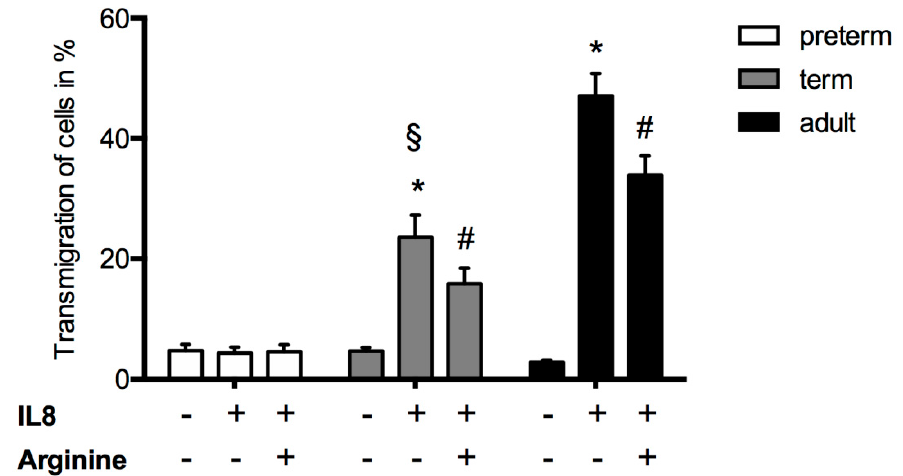
Figure 3. Leukocyte transmigration is decreased by L-arginine in term infants. Leukocyte transmigration of preterm and term infants and adults was analyzed in transmigration assays in the presence or absence of an IL-8 gradient and or incubation with 10 µg/mL L-arginine for 45 min. Results are presented as mean + SEM from at least 5 separate individuals/experiments per group. Statistical analysis was performed by two-way ANOVA and Tukey’s post hoc analysis. Significance was set at p < 0.05. * indicates significance compared to controls (IL-8 (–), arginine (–)), # indicates significant downregulation of transmigration compared to IL-8 stimulated cells (IL-8 (+), arginine (–)) and § indicates significant differences to both preterm and adult IL-8 stimulated cells (IL-8 (+), arginine (–)).